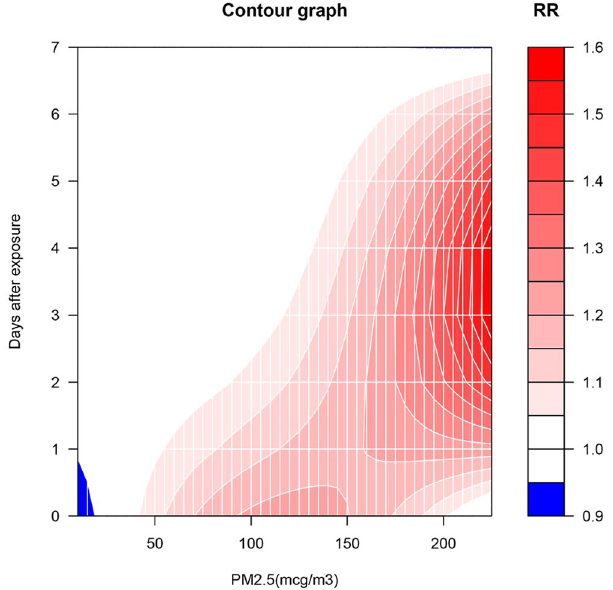
Figure 2. Contour plot showing adjusted effect of PM2.5 on relative risk (RR) of ICUp, setting the reference at PM2.5 of 30 mcg/m3. At a PM2.5 < 50 mcg/m3, there was no additional risk of ICUp. The RR increases with increasing PM2.5 concentrations. Furthermore, the effect size of PM2.5 reached its plateau at 3 to 4 days after exposure. Thereafter, the effect decreased gradually and returned to normal after 6 to 7 days.